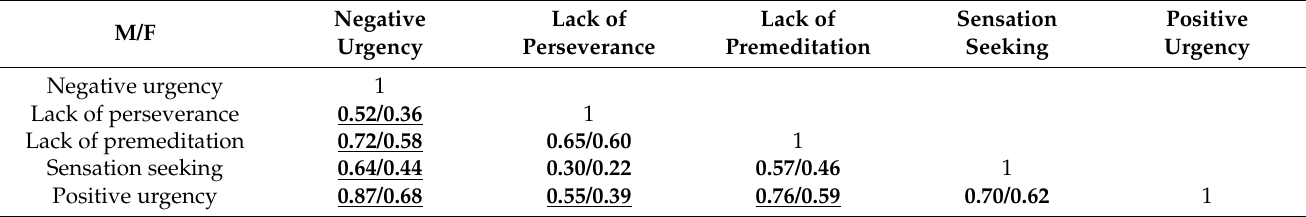
Table 4. Pearson correlation matrixes.